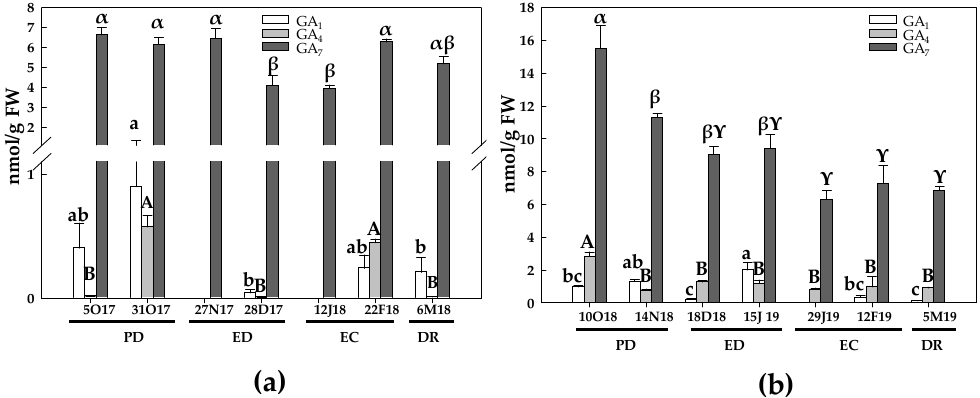
Figure 16. Evolution of gibberellins contents in flower buds of peach ‘GEM020’ cultivated in a temperate area during the dormancy cycle on two seasons. ( a ): season 1 (2017–2018); ( b ): season 2 (2018–2019). Data represent the mean ± SE, n = 5. Different letters (lowercase, uppercase and Greek letters for GA 1 , GA 4 and GA 7 , respectively) indicate significant differences according to Tukey’s multiple test ( p ≤ 0.05). PD: paradormancy; ED: endodormancy; EC: ecodormancy; DR: dormancy release. FW: fresh weight. The chill units accumulated at the different times and locations are shown in Supplemental file 1.